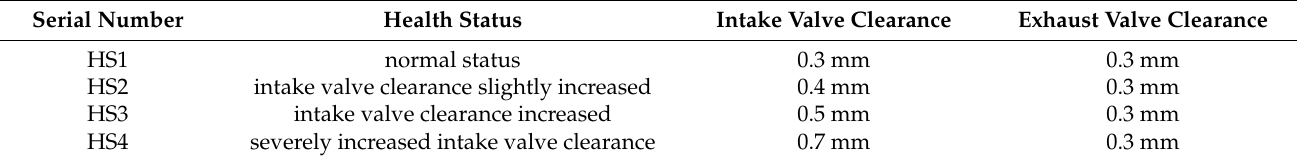
Table 3. Valve clearance